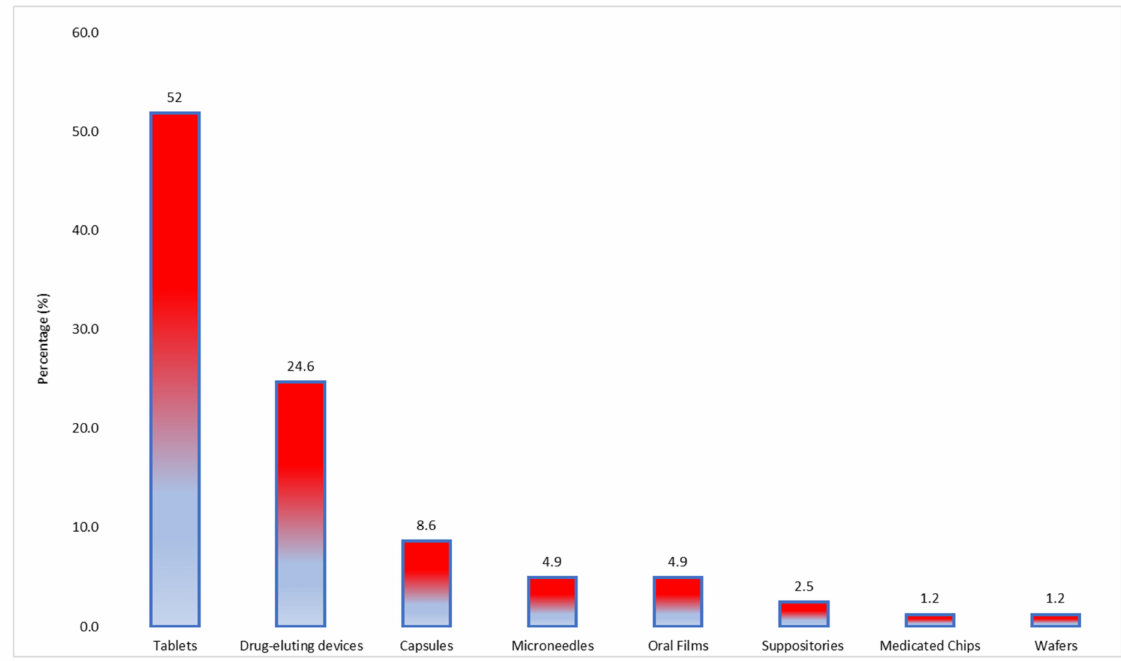
Figure 13. Dosage forms reported in the studies included in the systematic